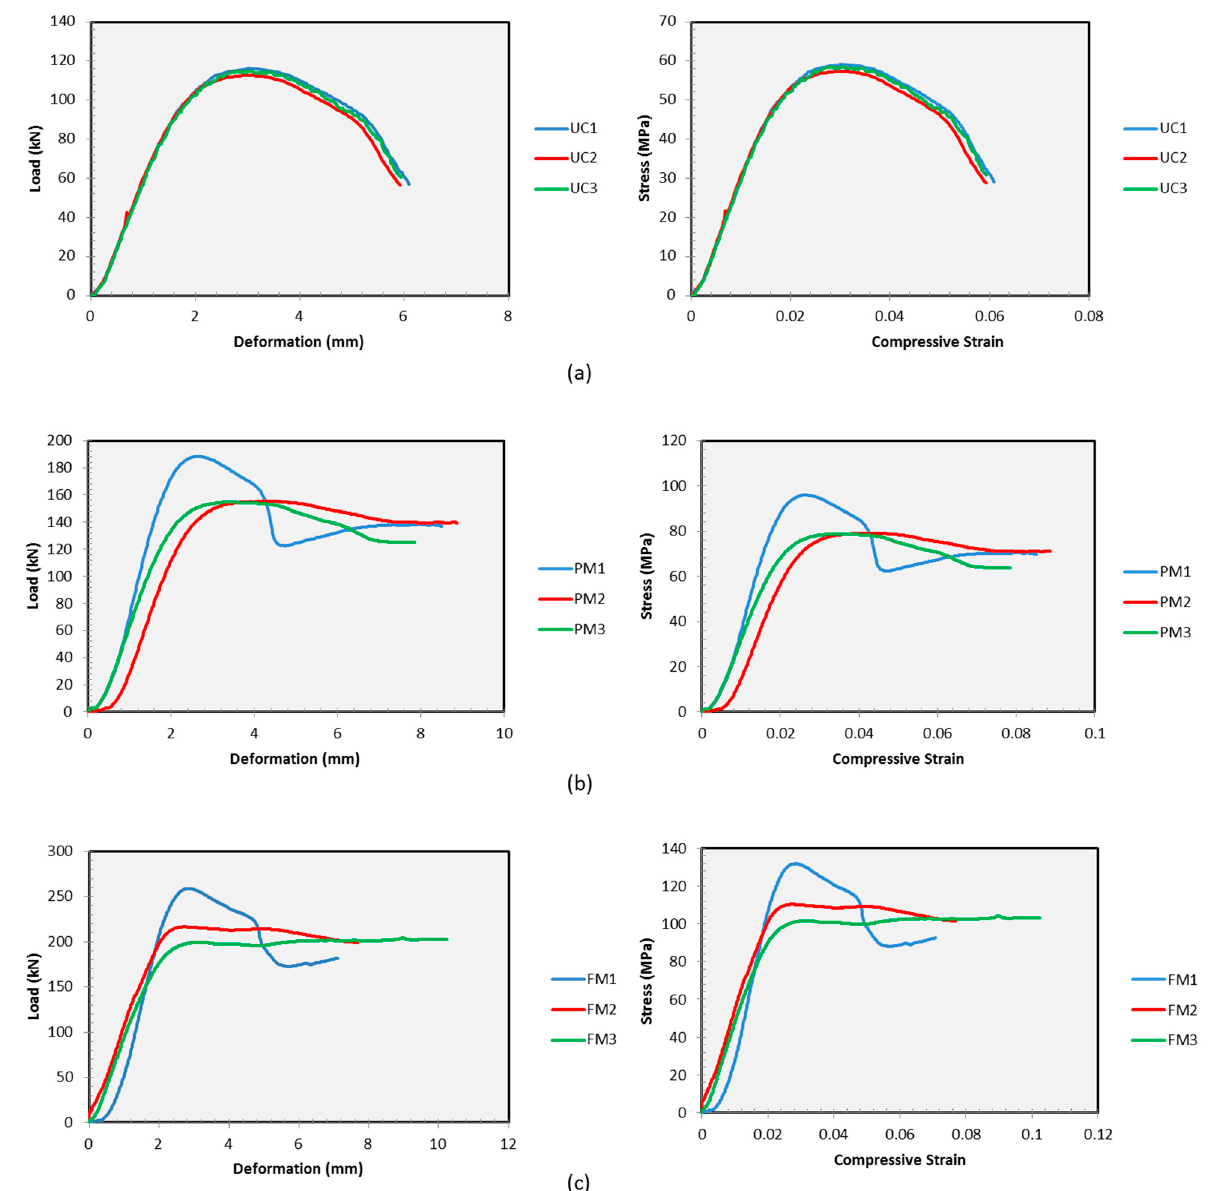
Figure 7. Load/stress versus deformation/strain curve. ( a ) Unconfined TSPC (UC). ( b ) TSPC with partial metal tube confinement (PM). ( c ) TSPC with fully metal tube confinement (FM).